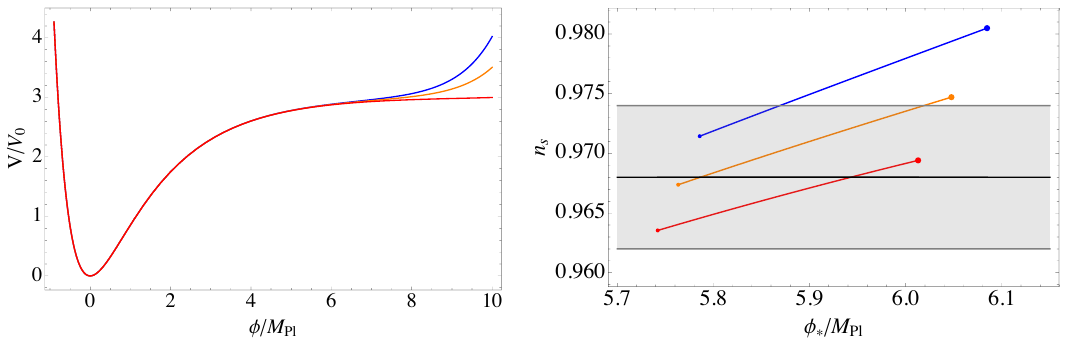
(cid:0) 7 (red), (cid:15) = 5 (cid:2) 10 (cid:0) 6 0 for (cid:15) = 10